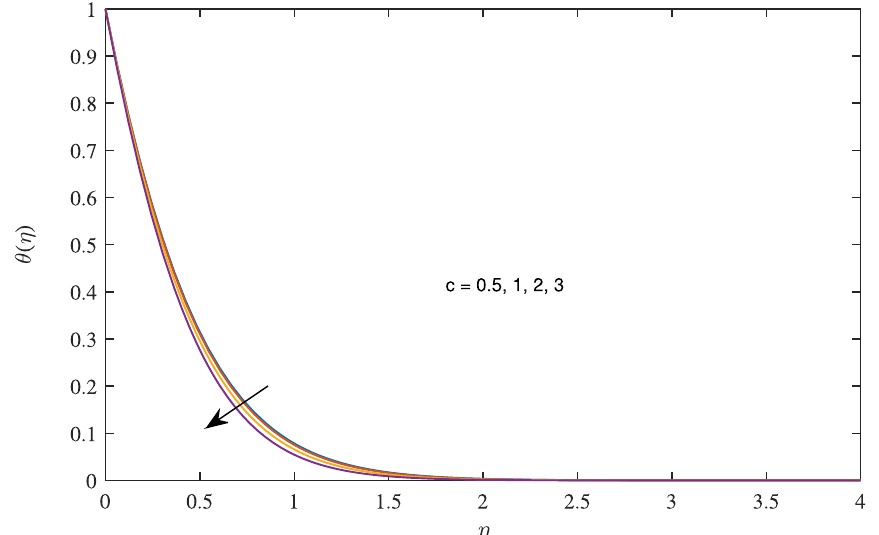
0.1 , β 0.1 0.5 , ζ 0.2 , N 1 , φ rd = = = = ◦ =